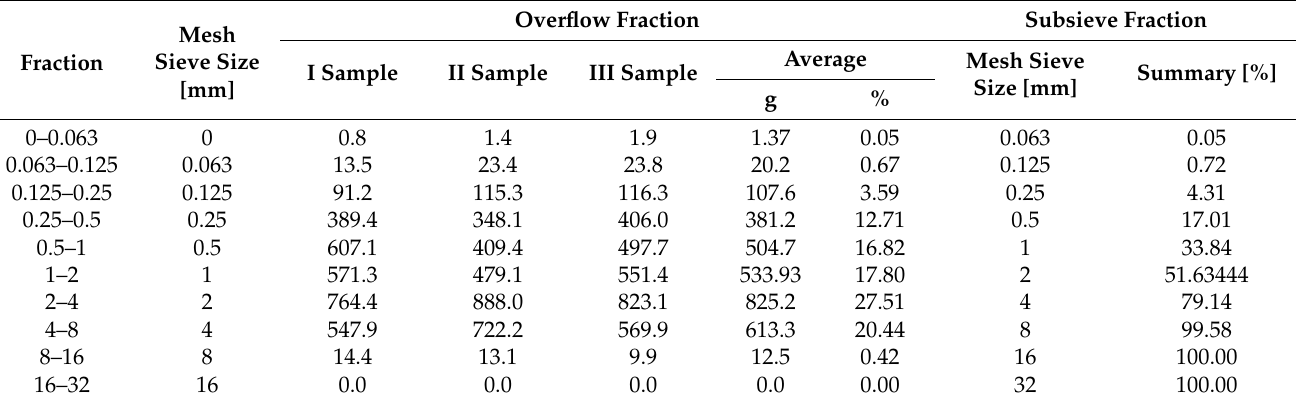
Table 3. MSWIBA sieve